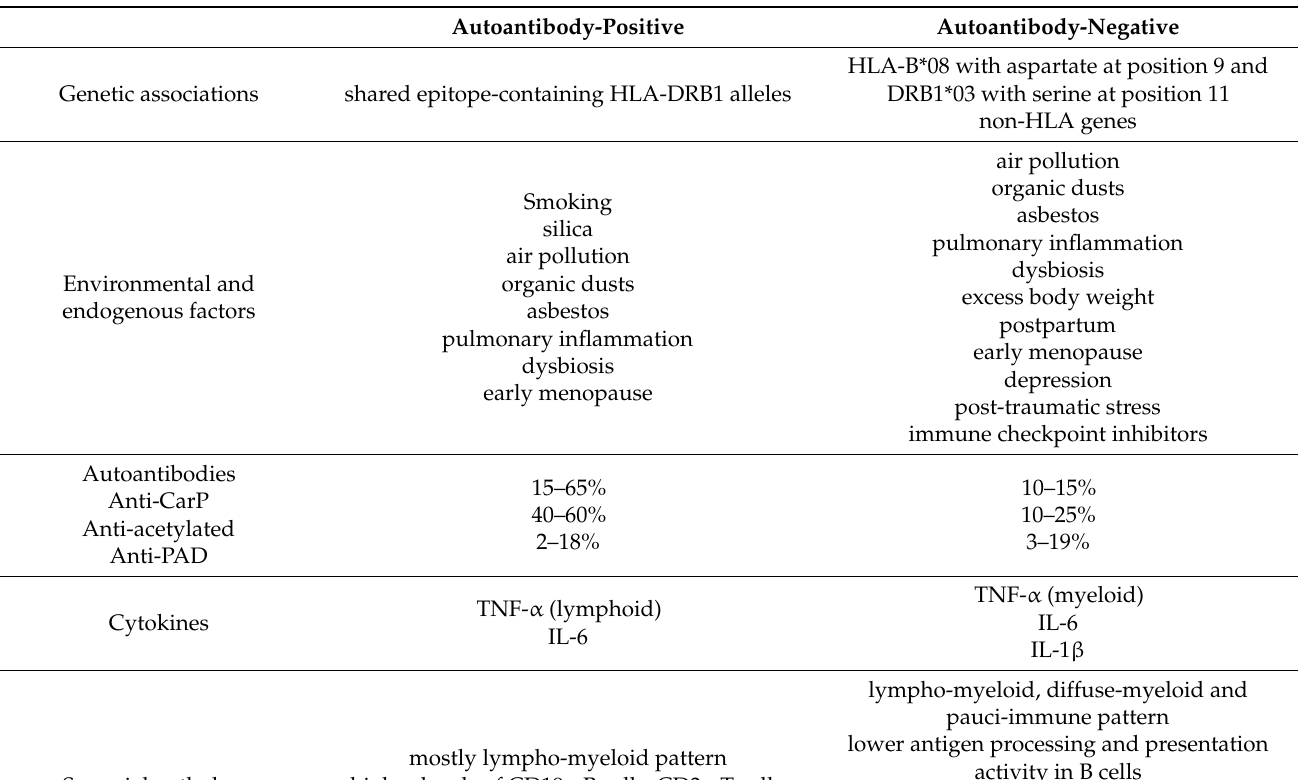
Table 1. Genetic, environmental, and immunopathologic differences between autoantibody-positive and -negative rheuma- toid